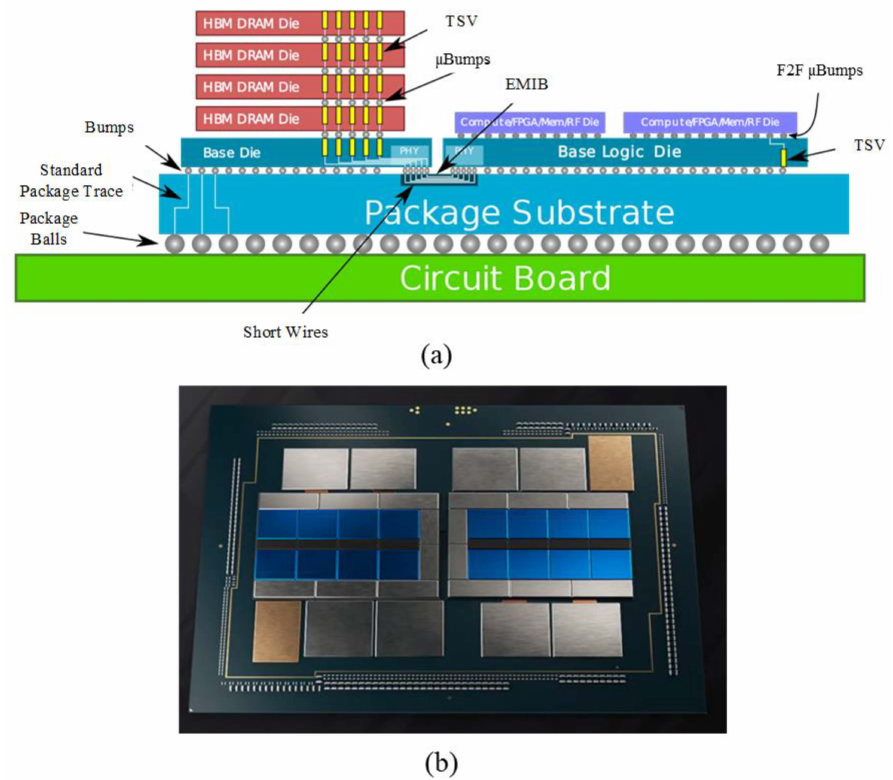
Figure 8. ( a ) Co-EMIB 3D Integration Technology (reprinted from Ref. [50], Copyright 2020, with permission from IEEE); ( b ) Ponte Vecchio GPU architecture (reprinted from Ref. [51], Copyright 2021, with permission from IEEE).